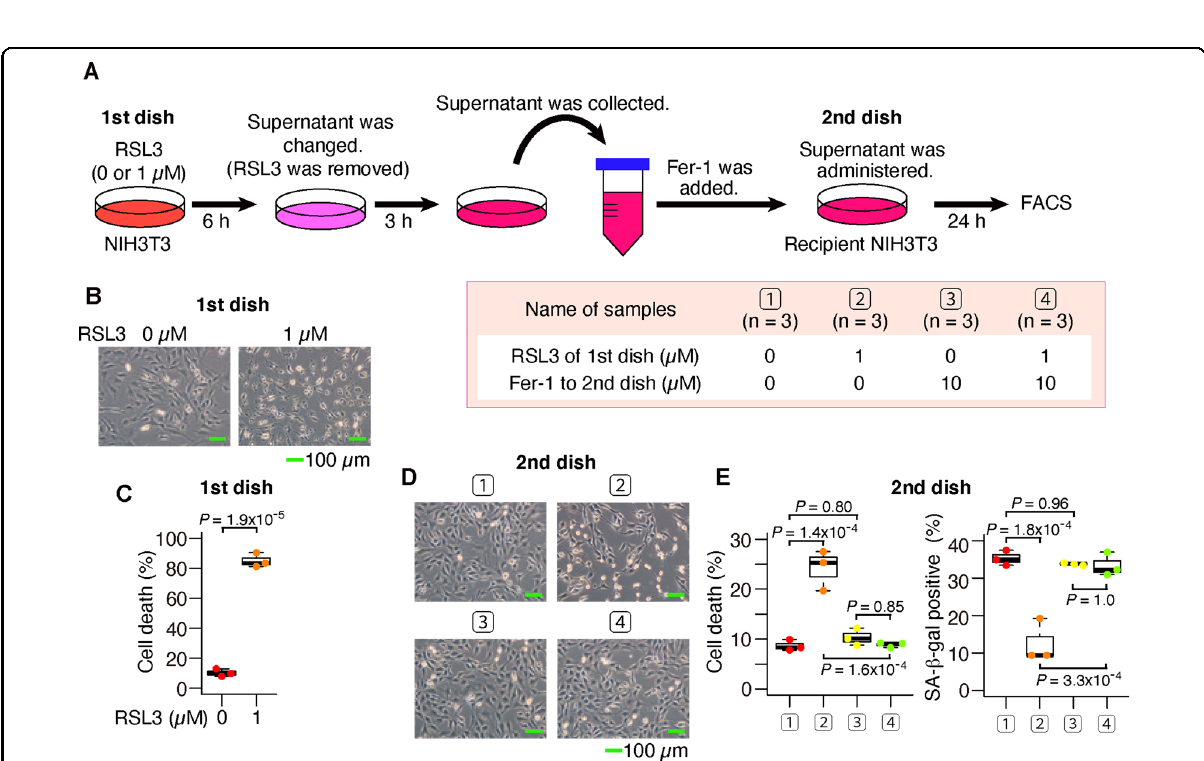
Fig. 4 The supernatant from RSL3-induced ferroptotic cells also increased cell death and decreased SA- β -gal in recipient cells. A – D After NIH3T3 cells had been exposed to (1S, 3R)-RSL3 for 6h, the supernatant medium was exchanged (RSL3 was removed). After 3h, the supernatant medium was collected and administered to recipient NIH3T3 cells. A Experimental outline. B , C These are data of donor NIH3T3 cells. B Optical microscope image. C Quanti fi cation of dead cells by fl ow cytometer. D , E These are data of recipient NIH3T3 cells. D Optical microscope image. E Quanti fi cation of dead cells and SA- β -gal-positive cells by fl ow cytometer. Scale bars in B and D represent 100µm. The box-and-whisker plots of C and E show the 25th and 75th percentile quartiles and median values (center black line) and maximum and minimum values of the data. P value of C by two-sided t test. P value of E by Tukey ’ s test after two-way